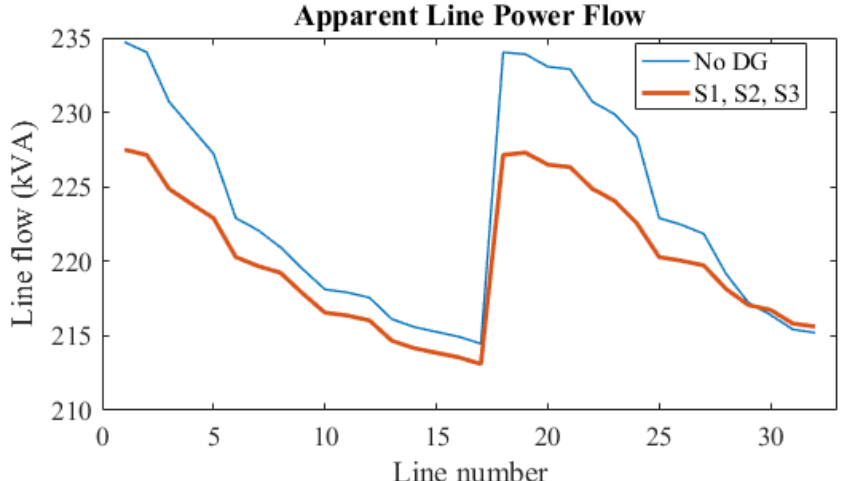
Figure 11. Power flow along each branch.